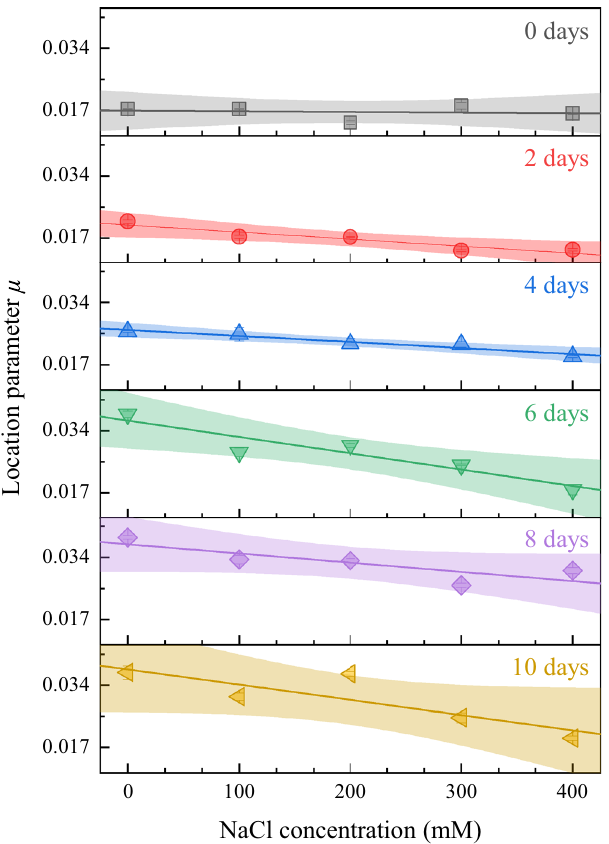
Figure 3. Median (symbols) and linear regression (lines) with 95% confidence range (shades) of location parameter μ for five replicants with different durations of treatments as a function of the concentration of NaCl.